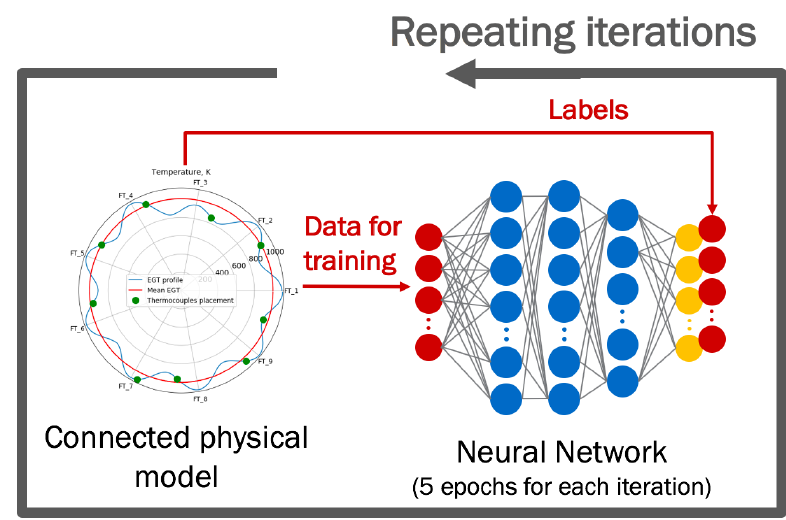
Figure 9. Architecture of a combined